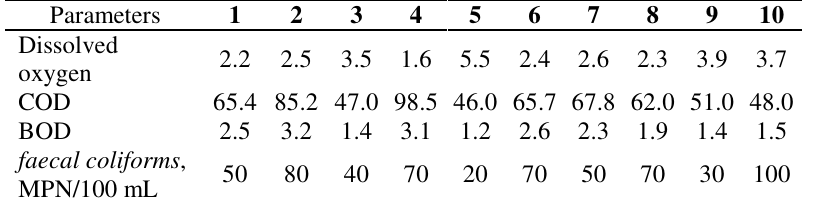
Table 3. Biological parameters, in